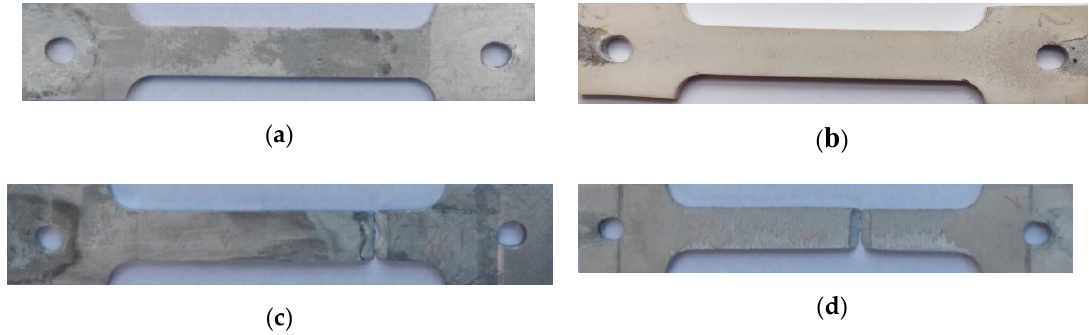
Figure 5. Images of samples after stress corrosion tests of AlMg6 alloy with sheet thickness g = 6 mm, ( a ) without coating, ( b ) with coating, ( c ) without cover after breaking, ( d ) with a coating after breaking.